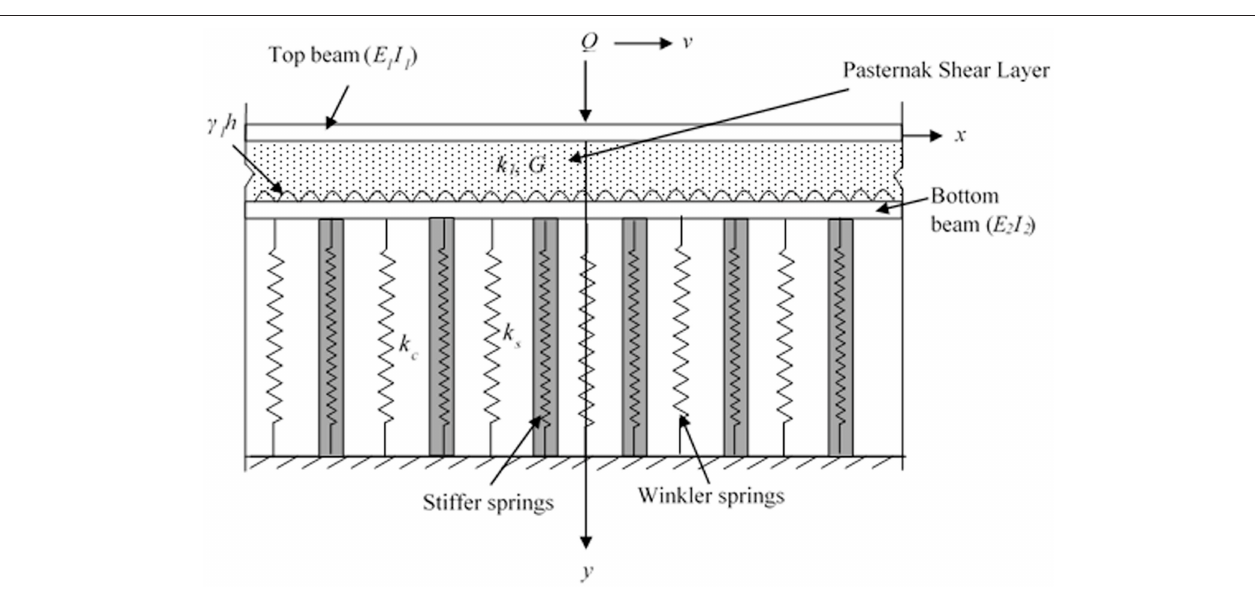
Where, the deflections of top and the bottom beam have been denoted by y 1 and y 2, respectively, and deflection of ground surface by y g . g is the acceleration due to gravity and a contact function j ( x , t ) has been included in the equations to